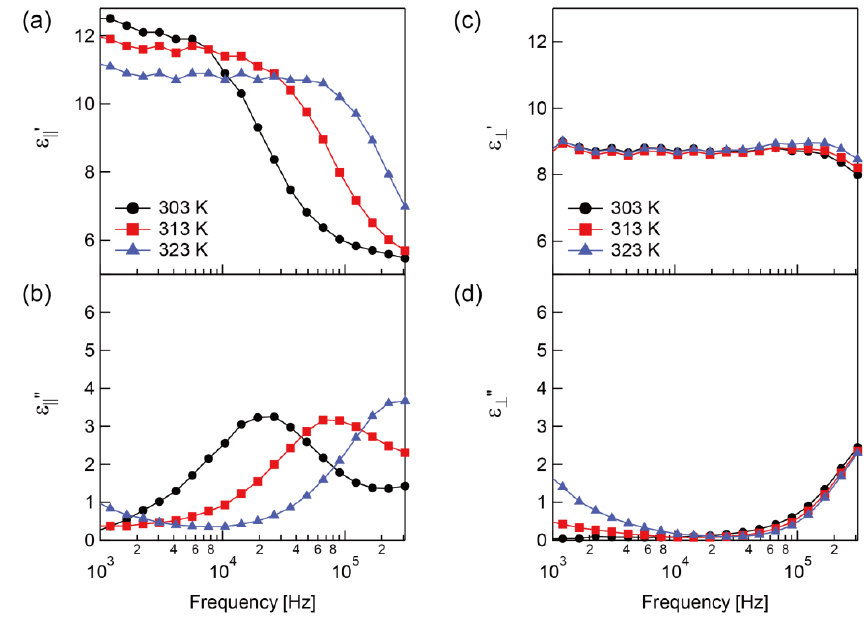
Figure 2. Measured complex dielectric constants before polymerization. The ( a ) real part; ( b ) imaginary part of complex dielectric constant parallel to the molecular long axis and the ( c ) real part and ( d ) imaginary part of complex dielectric constant perpendicular to the molecular long